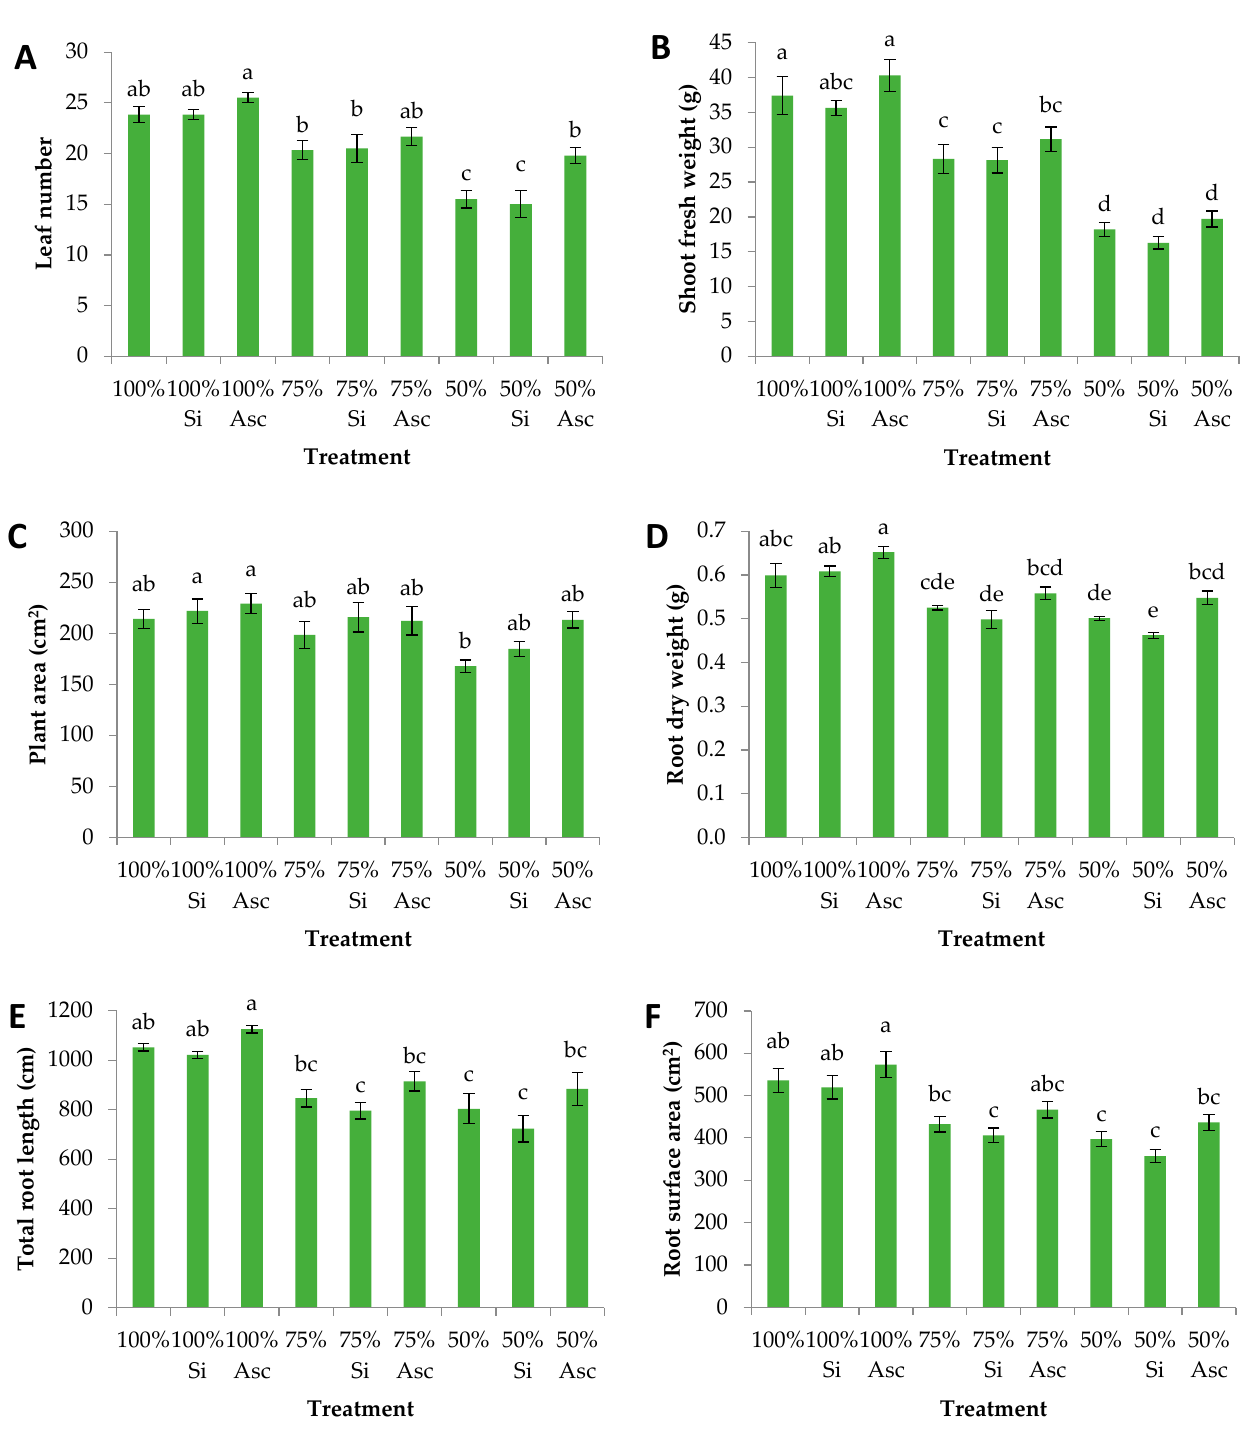
Figure 1. ( A ) Leaf number, ( B ) shoot fresh weight, ( C ) plant area, ( D ) root dry weight, ( E ) total root length, and ( F ) root surface area of watermelon plants 20 days after transplantation treated with two biostimulants (Si: silicon-based, and Asc: Ascophyllum nodosum seaweed) and additionally irrigated with different amounts of nutrient solution. Mean values (n = 6; ± SE) within a row followed by different letters are significantly different (a < 0.05).